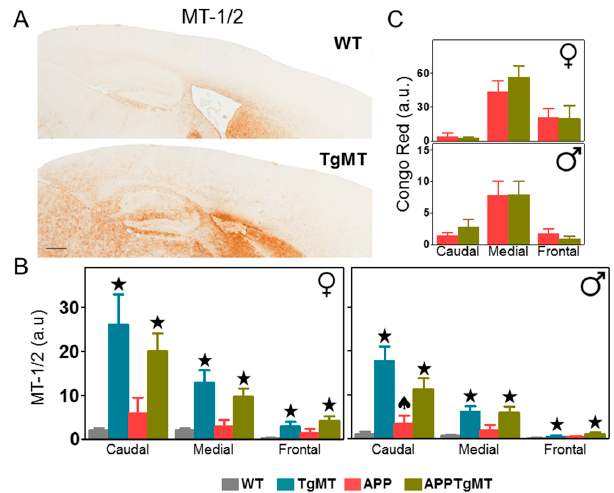
Figure 1. Effect of Mt1 overexpression on MT-1/2 and Congo Red staining in the cortex. ( A ) Representative brain MT-1/2 immunostaining in wild-type (WT) ( top ) and TgMT ( bottom ) mice; ( B ) Quantification of MT-1/2 IHC of the different genotypes in the cortex showed a dramatic increase in Mt1 -expressing (TgMT and APPTgMT) mice ( (cid:70) p at least ≤ 0.05 vs. WT or APP mice, respectively) with a prominent caudal-frontal gradient. As revealed by the significant interaction between APP expression and Mt1 overexpression ( ♠ p < 0.05 in male caudal region; the rest was not significant), APP expression tended towards an increase in MT-1/2 in WT mice; and the opposite was true in TgMT mice; ( C ) The greatest accumulation of dense amyloid plaques (stained with Congo Red) was localized in the medial area in both sexes. Results are mean ± SEM ( n = 7–11). Scale bar: 400 µm. a.u., arbitrary units.